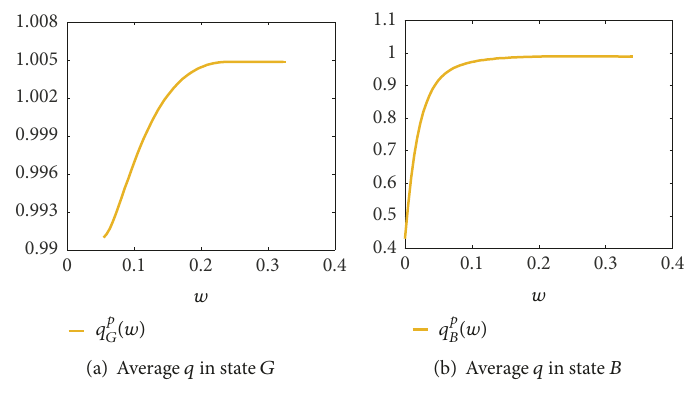
Figure 5: Average 𝑞 with time inconsistency in both